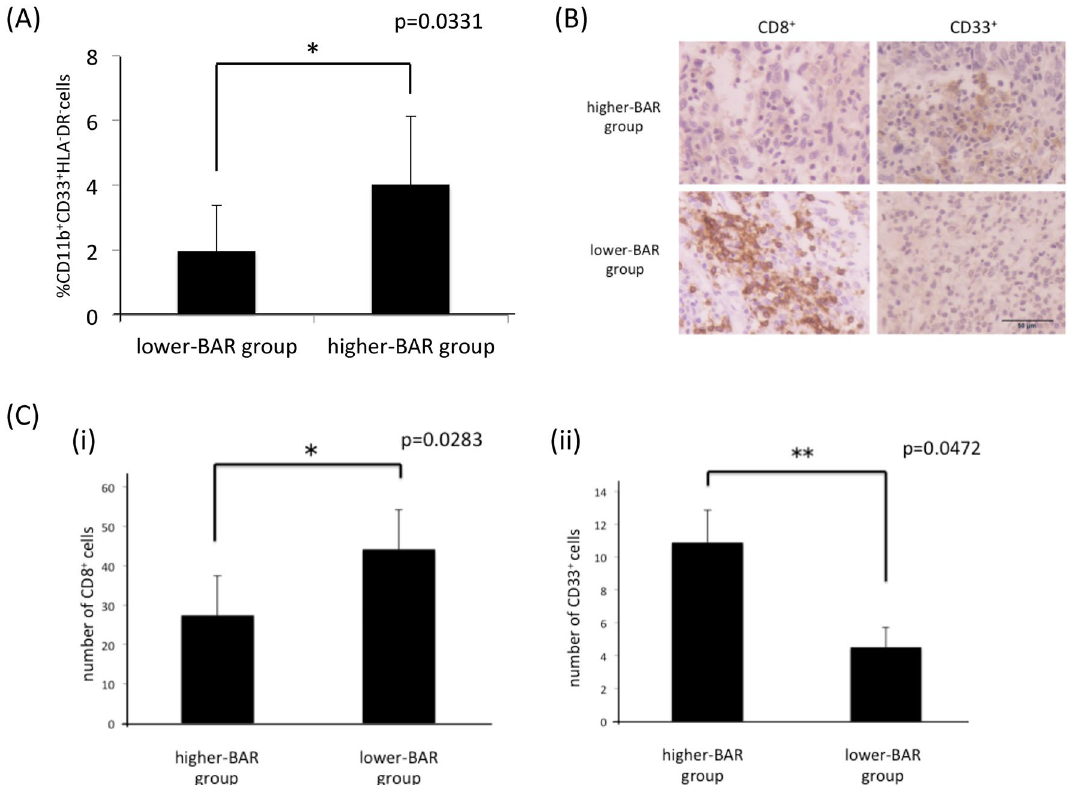
Figure 3. The association between BM FDG-uptake and MDSCs in patients with cervical cancer. ( A ) Circulating MDSC levels of patients with cervical cancer. Blood samples were obtained from the higher- BAR group (n = 5) and the lower-BAR group (n = 7). Human MDSCs, which were defined as CD11b + CD33 + HLA - DR - cells, were assessed using flow cytometry. Bars, SD. *p < 0.05, Wilcoxon rank sum test. ( B - C ), Immunoreactivities of cervical cancer for CD8 and CD33 according to BM FDG-uptake. Cervical tumor obtained from patients in the higher-BAR group (n = 5) and in the lower-BAR group (n = 7) were stained with anti-CD8 and anti-CD33 antibodies. ( B ) Representative images of primary tumors. (magnification: × 200). ( C ) Graphs depicting the number of CD8 + (i) and CD33 + cells. Tumor sections were observed using a bright field microscope (at × 200), and the number of CD8 + and CD33 + cells were counted. Then, the average value of 4 random fields is shown (Bars, SD, *p < 0.05, two-sided Student’s t